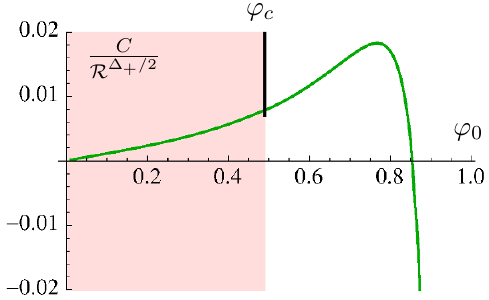
Figure 22. QFT on AdS d : C= R (cid:1) + = 2 vs. ’ 0 for the potential (5.1) with (cid:1) (cid:0) = 1 : 2. Flows with turning points in the rose-colored region exhibit a